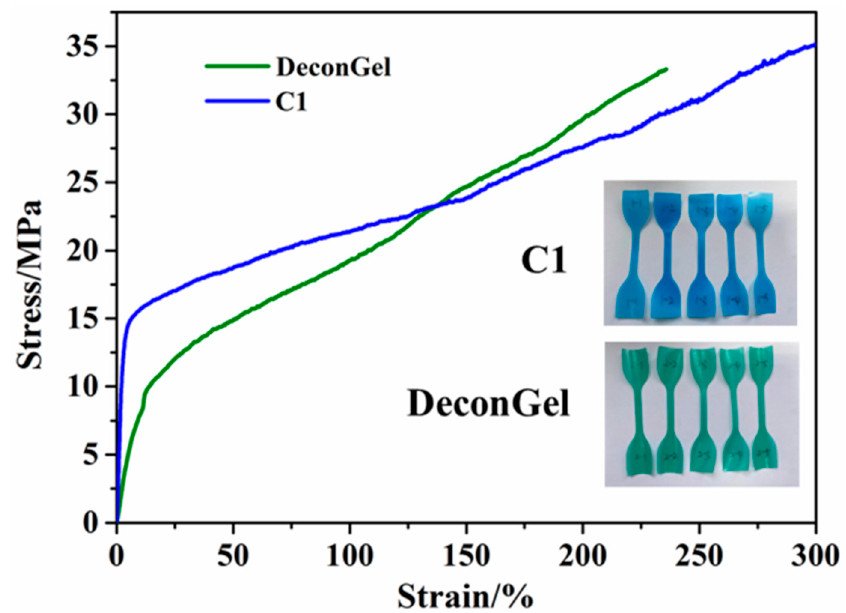
Figure 10. Stress–strain curves for polymeric coatings C1 and